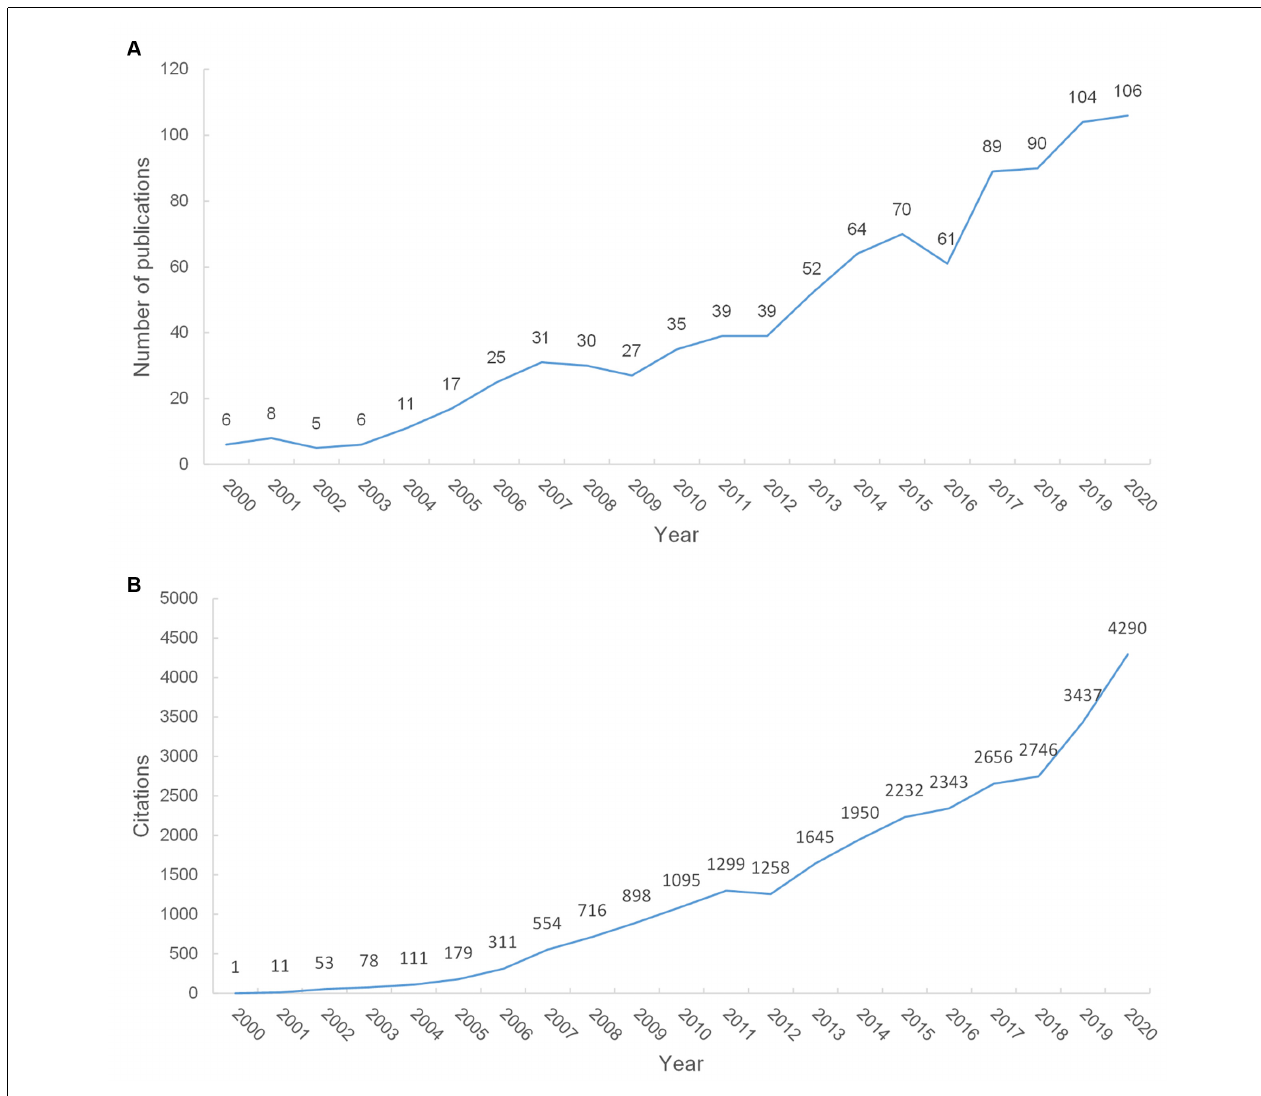
FIGURE 1 | The number of publications and citations. (A) The number of annual publications on Neuropathic pain (NP) associated with anxiety or depression research from 2000 to 2020. (B) The number of annual citations on NP associated with anxiety or depression research from 2000 to